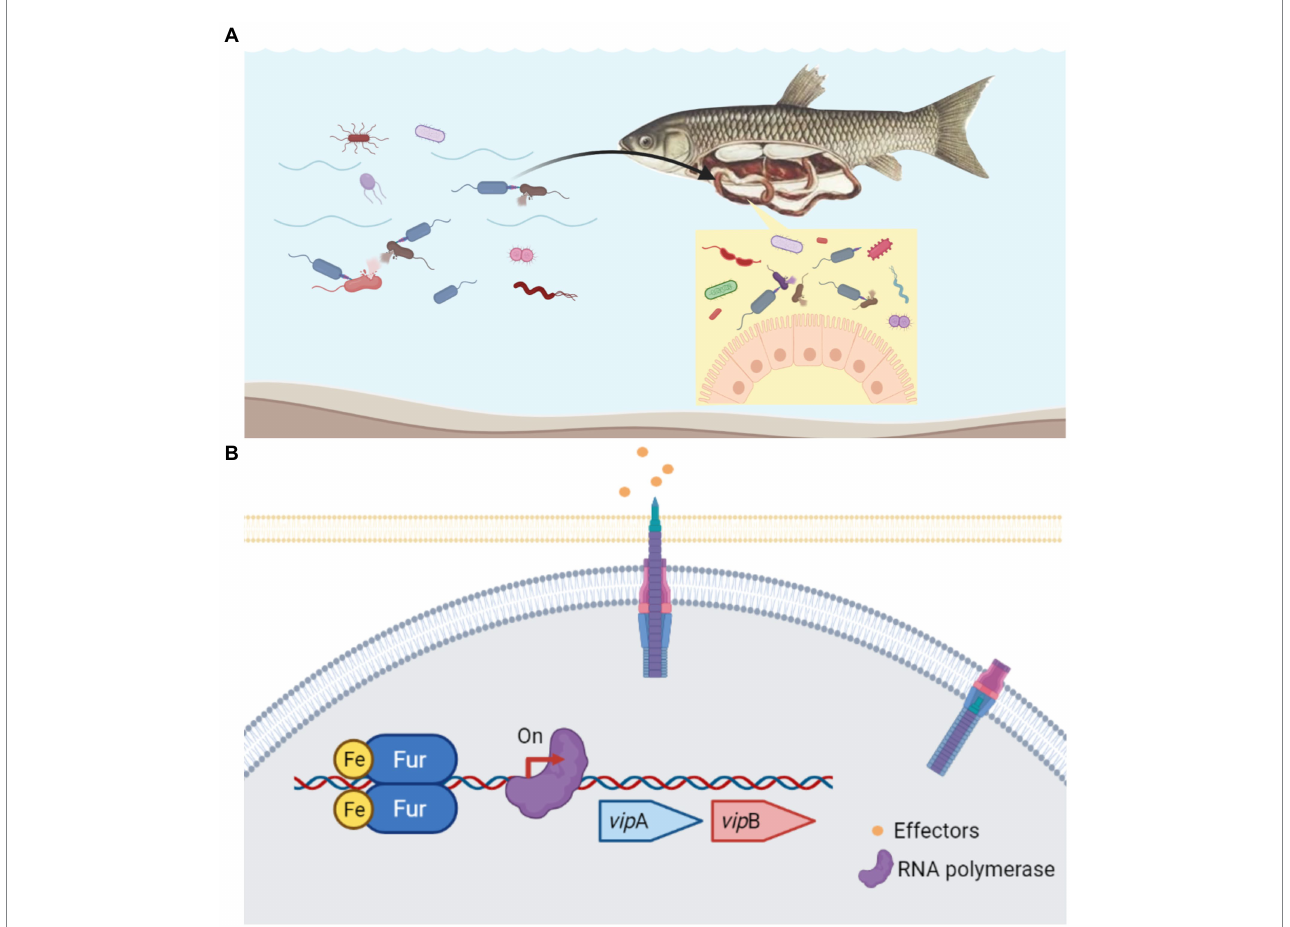
FIGURE 7 Schematic diagram of the Fur-mediated regulation of T6SS in A. hydrophila . (A) In the natural aquatic habitat or gastrointestinal tract of the host, A. hydrophila constantly has the problem of competing with other bacteria for niche under iron-replete conditions. (B) Under iron-replete conditions during infection, Fur binds in the promoter region of the T6SS vip A gene and promote the transcription. Fur protein in A. hydrophila could be a proper regulator to sense the iron concentration and work as the activator to regulate T6SS to compete with other